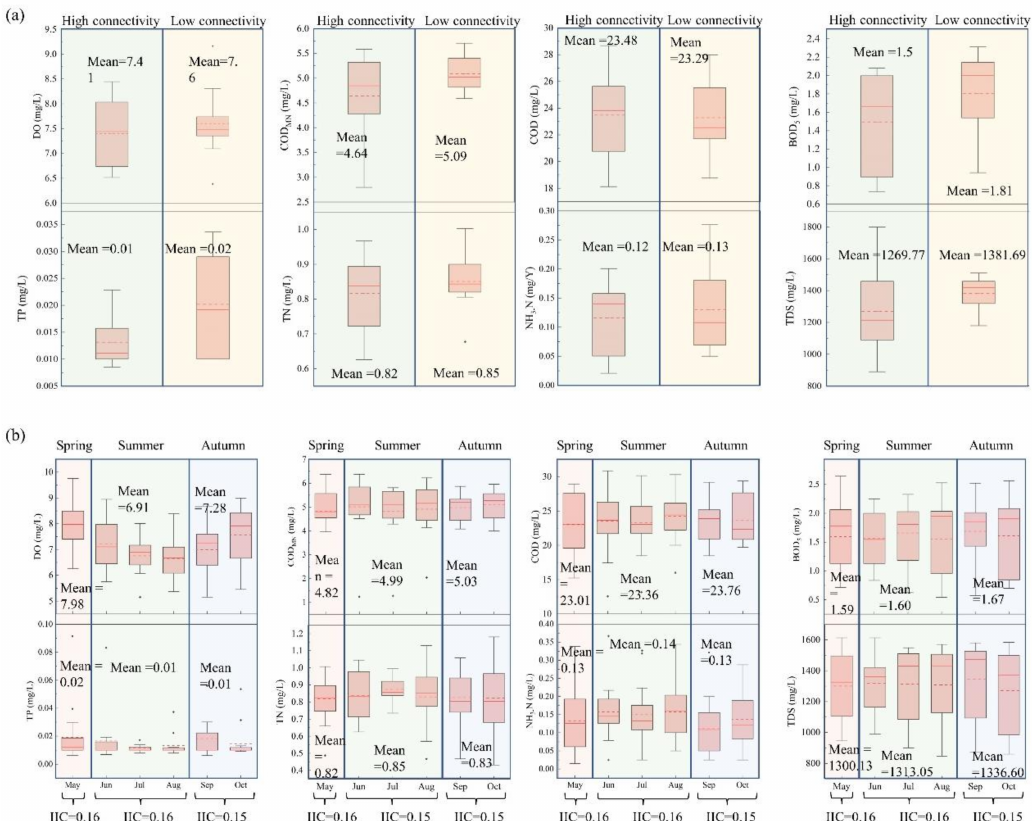
Figure 7. ( a ) Box line diagrams of 8 water quality indicators during high connectivity (green) and low connectivity (yellow) periods, respectively, dots represent the average concentration of each indicator per year; ( b ) Boxplots of 8 water quality indicators during May to October, respectively, where May is spring (red), June–August is summer (green), and September–October is autumn (blue). The meaning of the boxes and lines are the same with Figure 3d, dots represent the average concentration of each indicator per